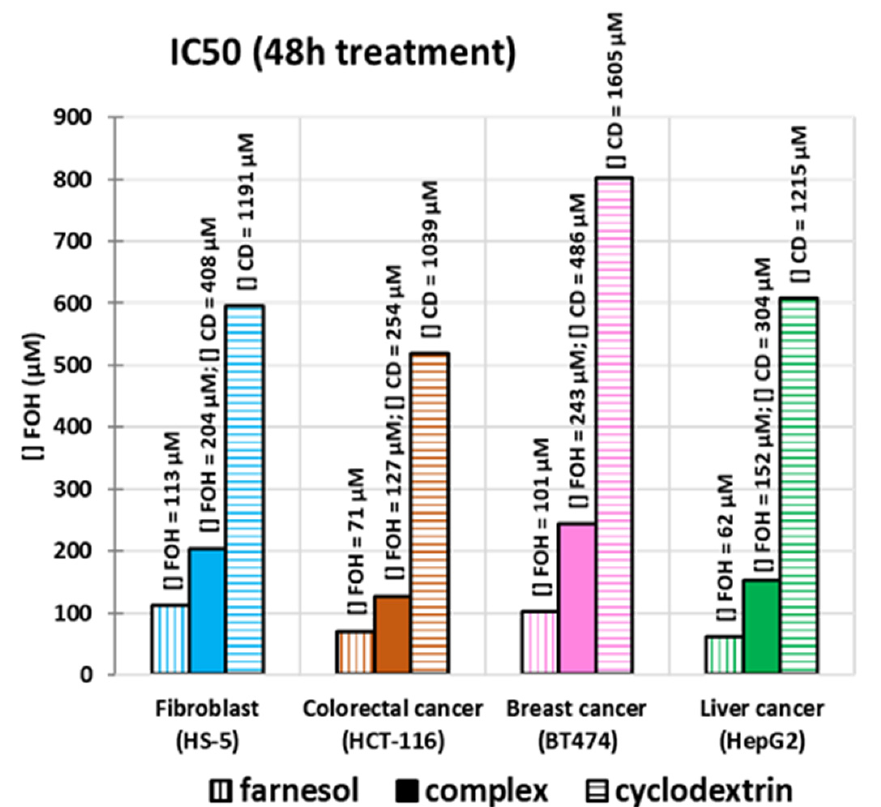
Figure 4. Graphical representation of IC50 estimation for FOH (vertically hatched columns), CD (horizontally hatched columns), and the complex (filled columns) in four cancer cell lines (blue—fibroblast, orange—colorectal, pink—breast, green–liver).